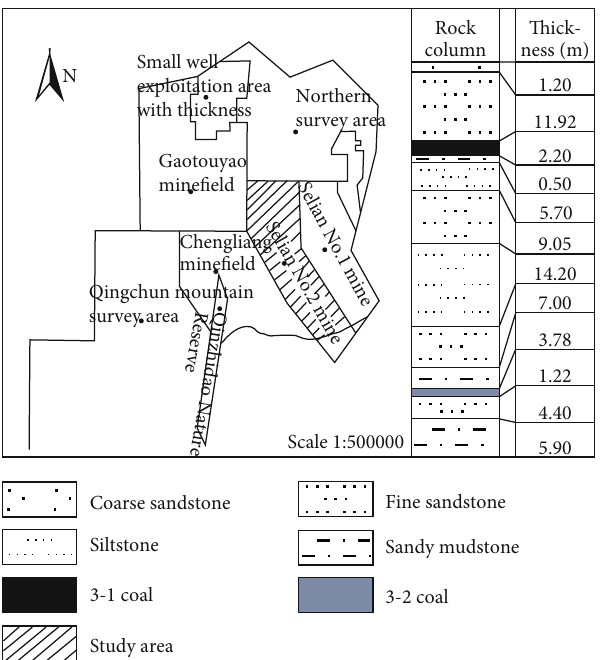
Figure 4: Location of the mining area and stratigraphic lithology